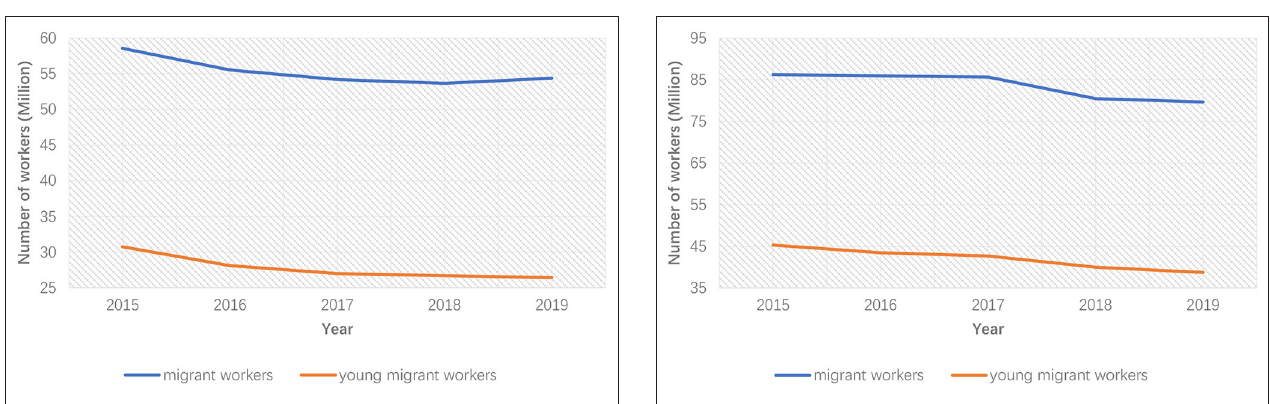
FIGURE 1 | The number of migrant workers and young migrant workers in the construction industry.